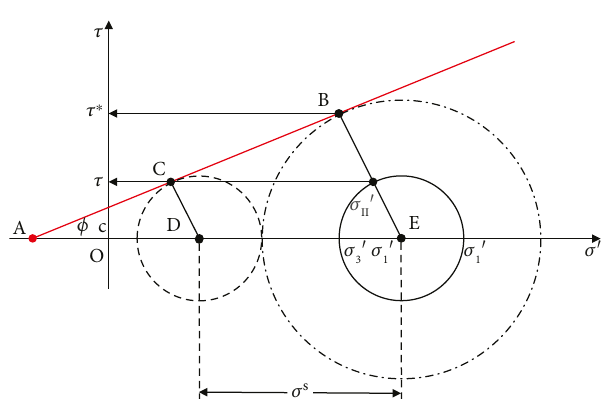
Figure 1: Conceptual illustration of the local factor of safety